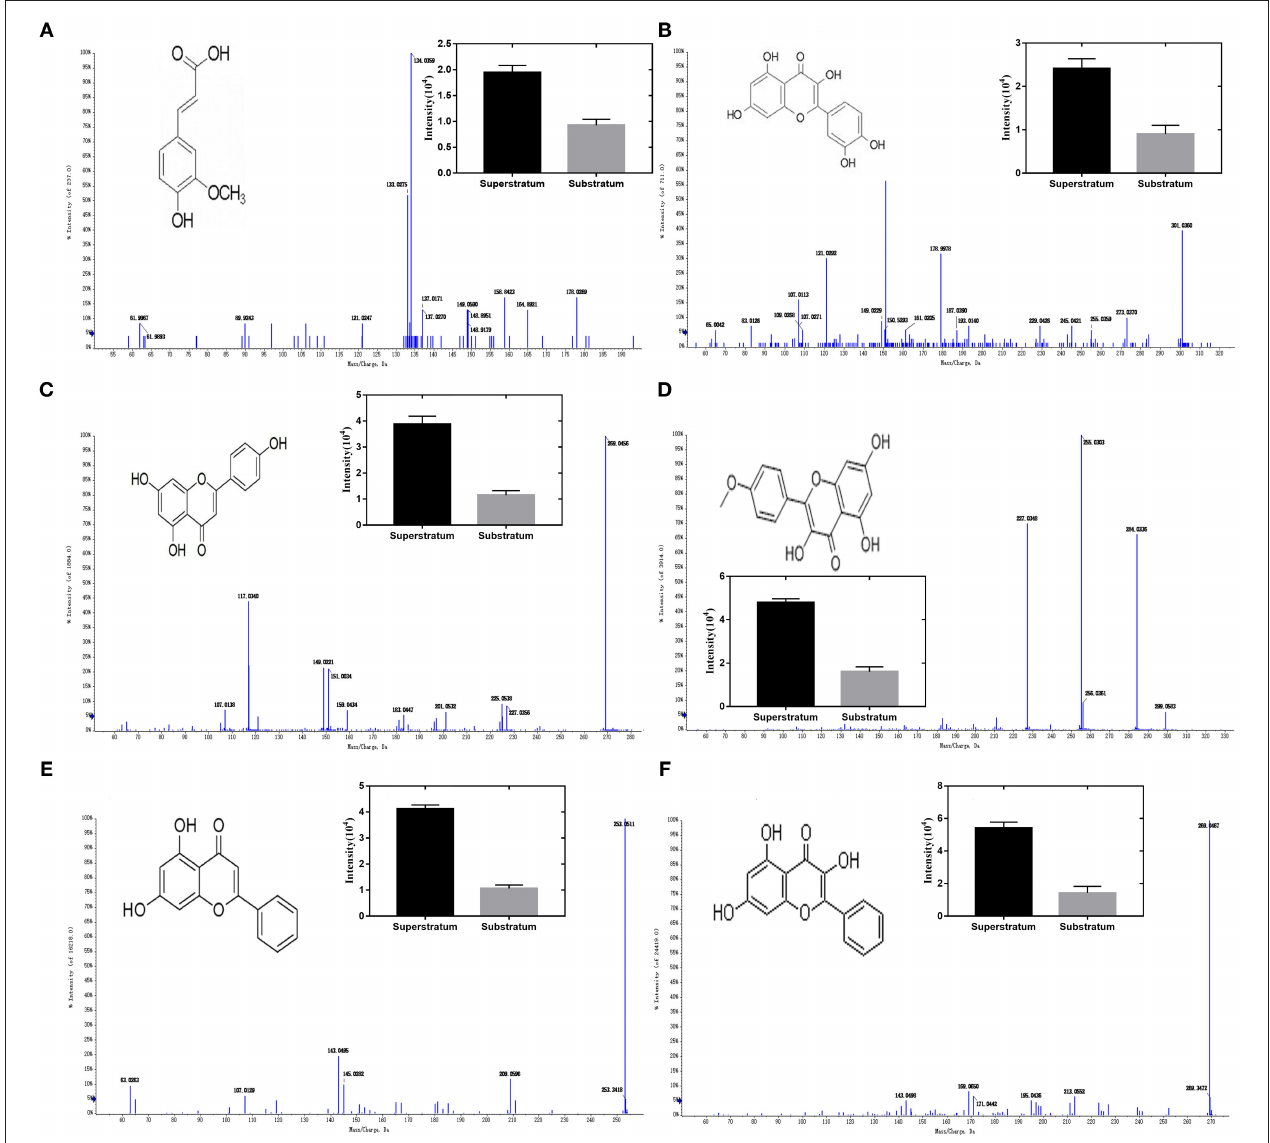
FIGURE 2 | Ion chromatogram of flavonoids in propolis. (A) Ferulic acid, (B) quercetin, (C) apigenin, (D) kaempferol, (E) chrysin, and (F) galangal.